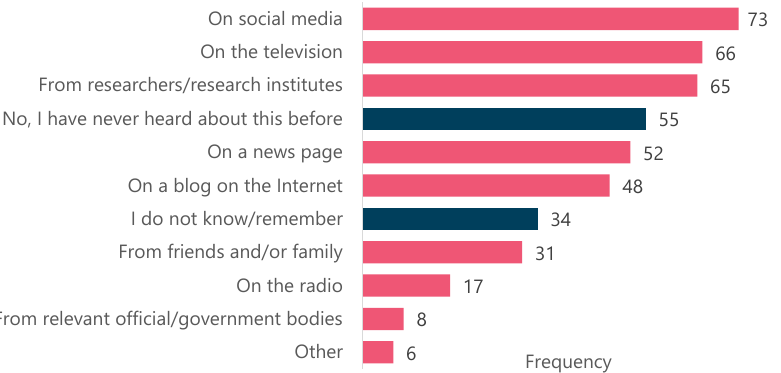
Figure 4. Frequency of reported source of information ( n = 455).